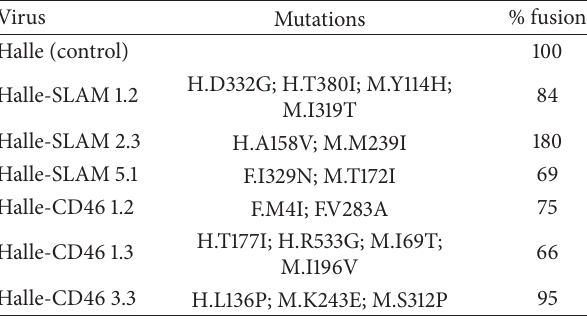
Table 3: Fusion capacities of the six escape mutants selected for further study relative to Halle.